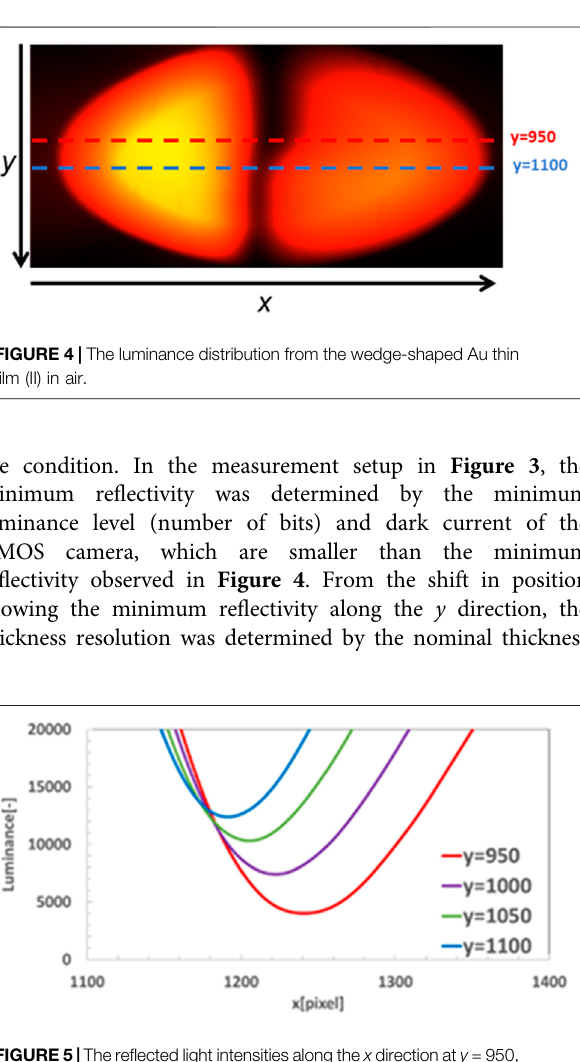
FIGURE5| There fl ected lightintensitiesalongthe x directionat y (cid:2) 950, 1,000, 1,050, and 1,100 based on Figure 4 .